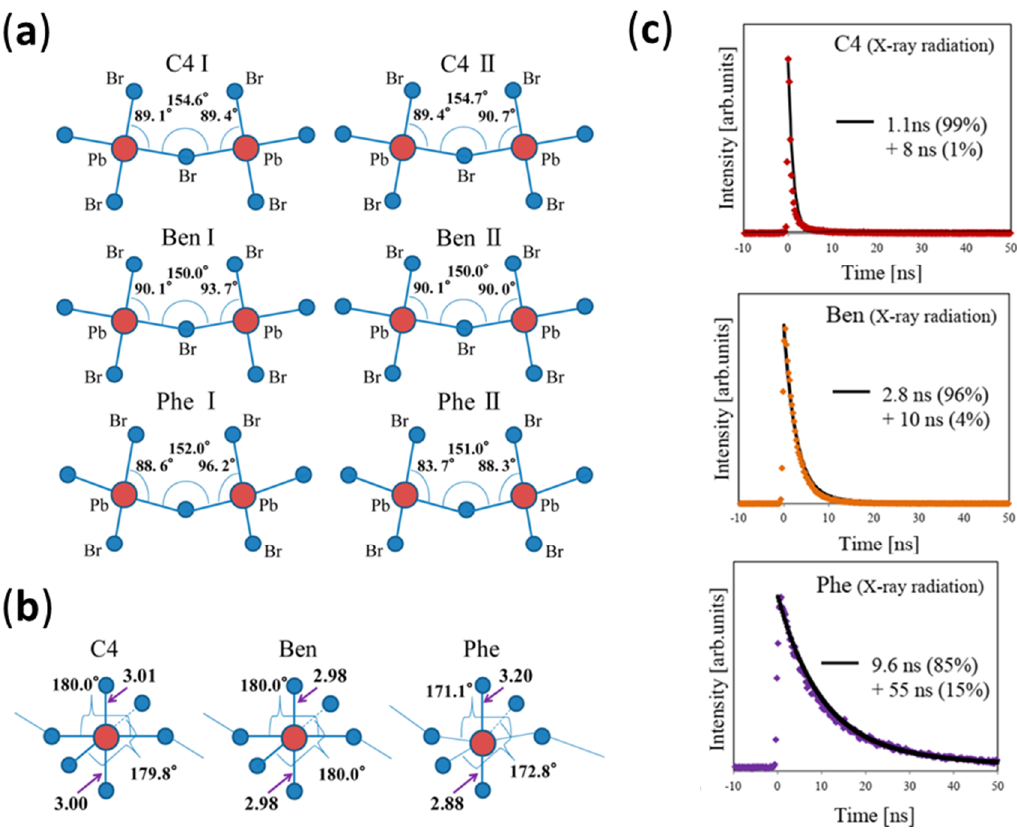
Figure 12. ( a ) Structural geometry between the adjoining PbBr 62− octahedra and inside PbBr 62− octahedra ( b ). Reproduced from Reference [165] with permission. ( c ) Scintillation decay profile of C4, ben, and Phe OHIP under X-ray irradiation. Reproduced from Reference [175] with permission.